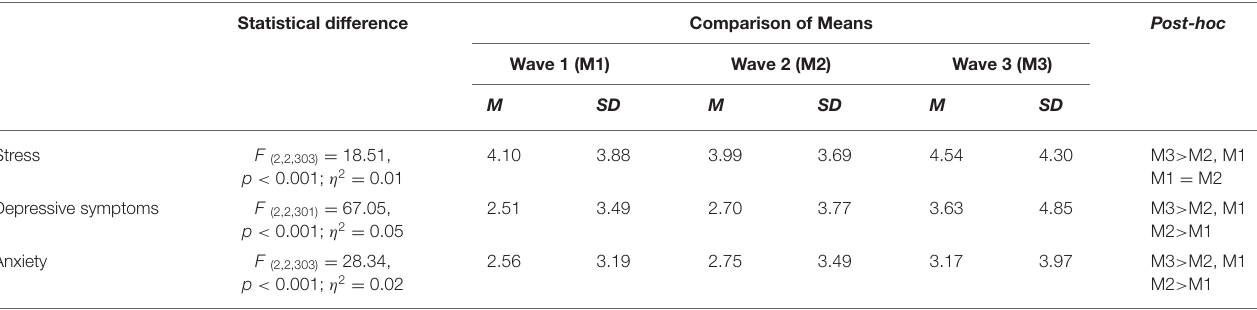
TABLE 3 | Comparisons of means in stress, depressive symptoms and anxiety by wave. Statistical difference Comparison of Means